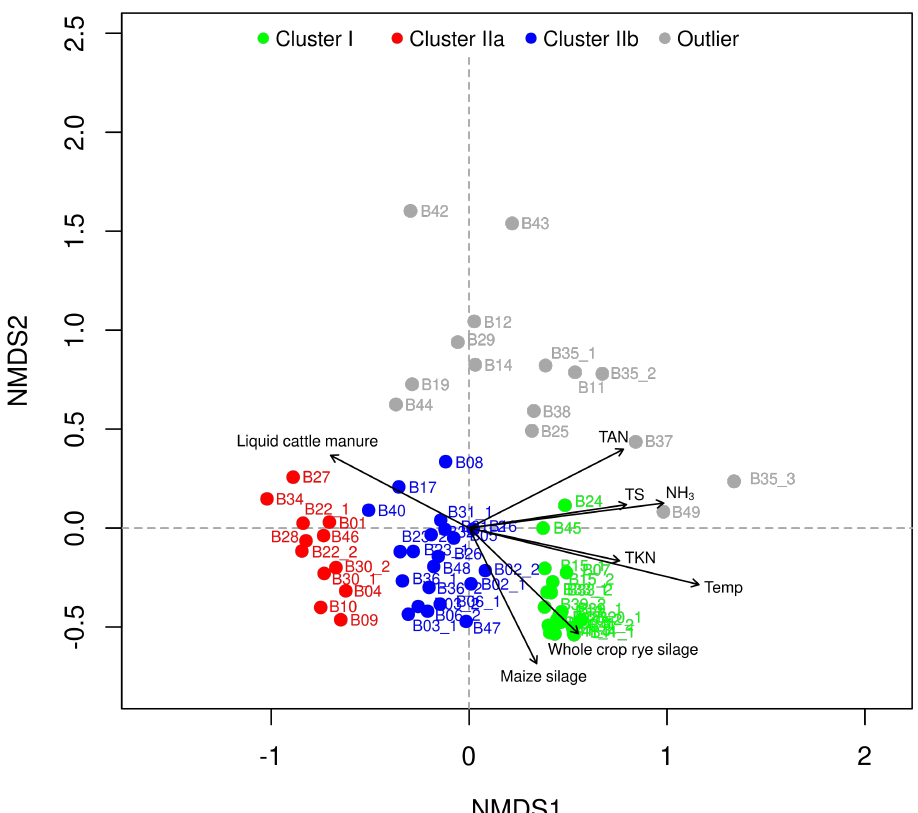
Figure 4. Non-metric multidimensional scaling (NMDS) based on the taxonomic diversity of the 67 analyzed digester samples from 49 agricultural, full-scale biogas plants. The color code is deduced from the tree diagram in Figure 3: Cluster I = green, cluster IIa = red, cluster IIb = blue, outlier = gray. The given environmental vectors symbolize the amount of maize silage ( R 2 = 0.30, p = 0.001), whole crop rye silage ( R 2 = 0.30, p = 0.001), liquid cattle manure ( R 2 = 0.32, p = 0.001), the process temperature ( R 2 = 0.74, p = 0.001), total solids (TS) ( R 2 = 0.33, p = 0.001), the total ammonium nitrogen (TAN) ( R 2 = 0.40, p = 0.001), the total Kjeldahl nitrogen (TKN) ( R 2 = 0.31, p = 0.001) and the free ammonia nitrogen concentration (NH 3 ) ( R 2 = 0.51, p =